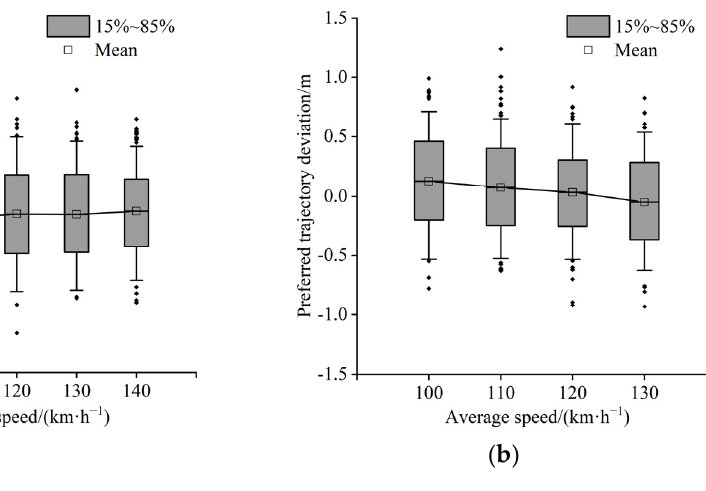
Figure 11. ( a ) Inner lane; ( b ) outside lane.